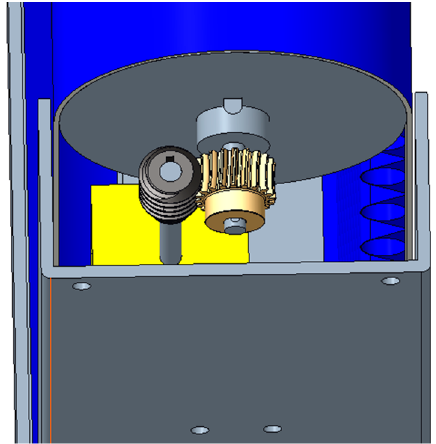
Figure 2. Possible mechanical design of the rotatable system.